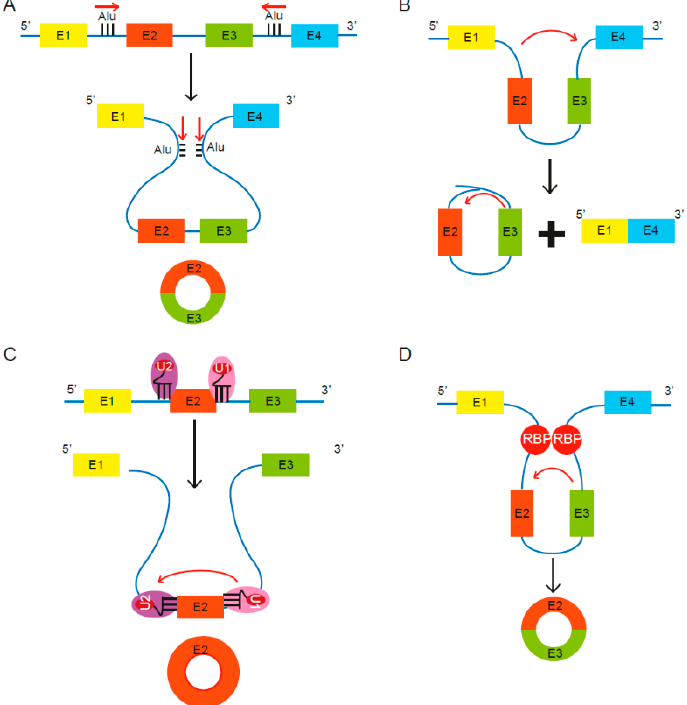
Figure 1. Proposed models of circular RNA (circRNA) biogenesis. Four proposed routes lead to the formation of circRNAs. ( A ) The pairing of intronic inverted repeat elements flanking either side of the exons leads to formation of circRNA [13]. ( B ) The alternative splicing mechanism “exon skipping” leads to an mRNA consisting of exons 1 and 4, as well as a lariat structure containing the skipped exons 2 and 3 [27]. ( C ) Under limited spliceosome activity, a shift from canonical splicing to back-splicing occurs that produces single-exon circRNAs, as cross-exon interactions are not replaced with cross-intron interactions [28]. ( D ) RNA binding proteins (RBPs) bind to recognition sites in introns near the circRNA-forming splice sites and promote circularization by bringing the circle-forming exons into close proximity [29,30].